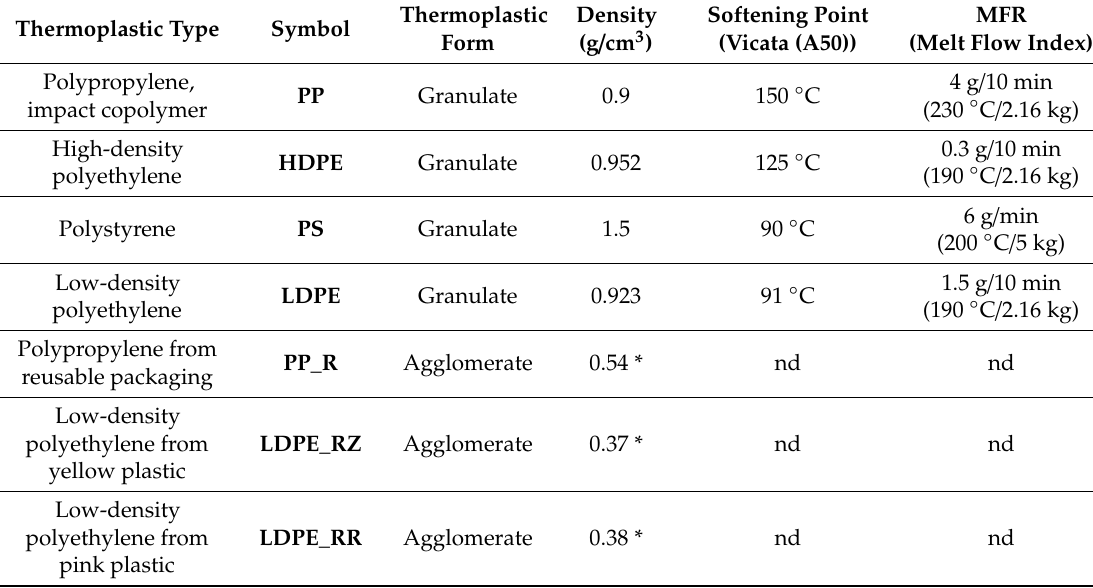
Table 1. Basic properties of the investigated